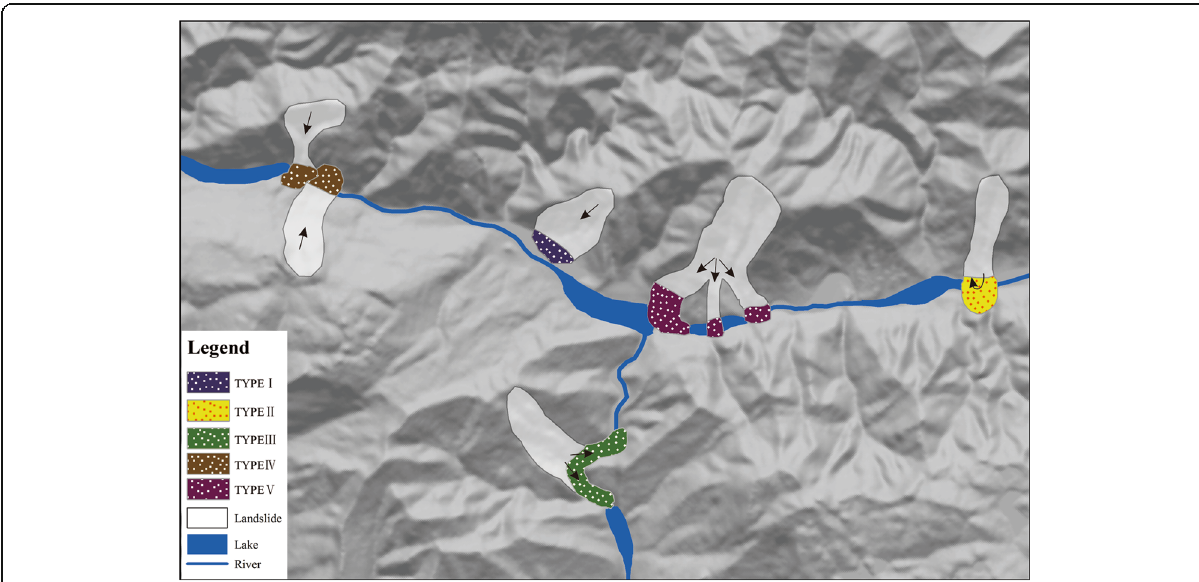
Fig. 13 Five main types of landslide dams based on the geomorphic features of landslide deposits